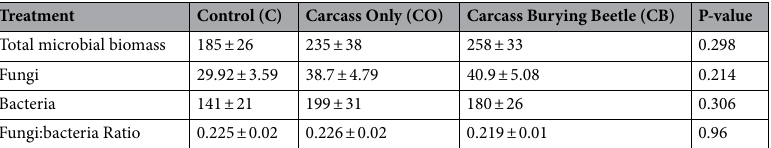
Table 2. Soil microbial biomass as estimated by phospholipid fatty acid (PLFA) analysis (nmol g − 1 dry soil) (means ± 1SE; n: C = 8, CO = 8, CB = 8). Effects of treatment were tested with a one-way ANOVA. * significant at P < 0.05 relative to the